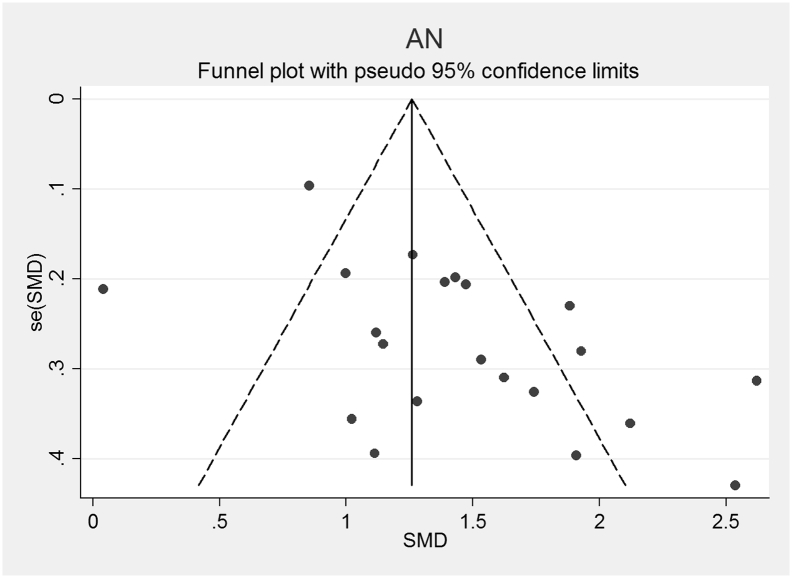
Funnel plot of Anorexia Nervosa (AN) studies included in the meta-analysis to assess for publication bias. Each dot represents a study included in the meta-analysis, with the Y axis representing the size of each study and the X axis, each study's result.